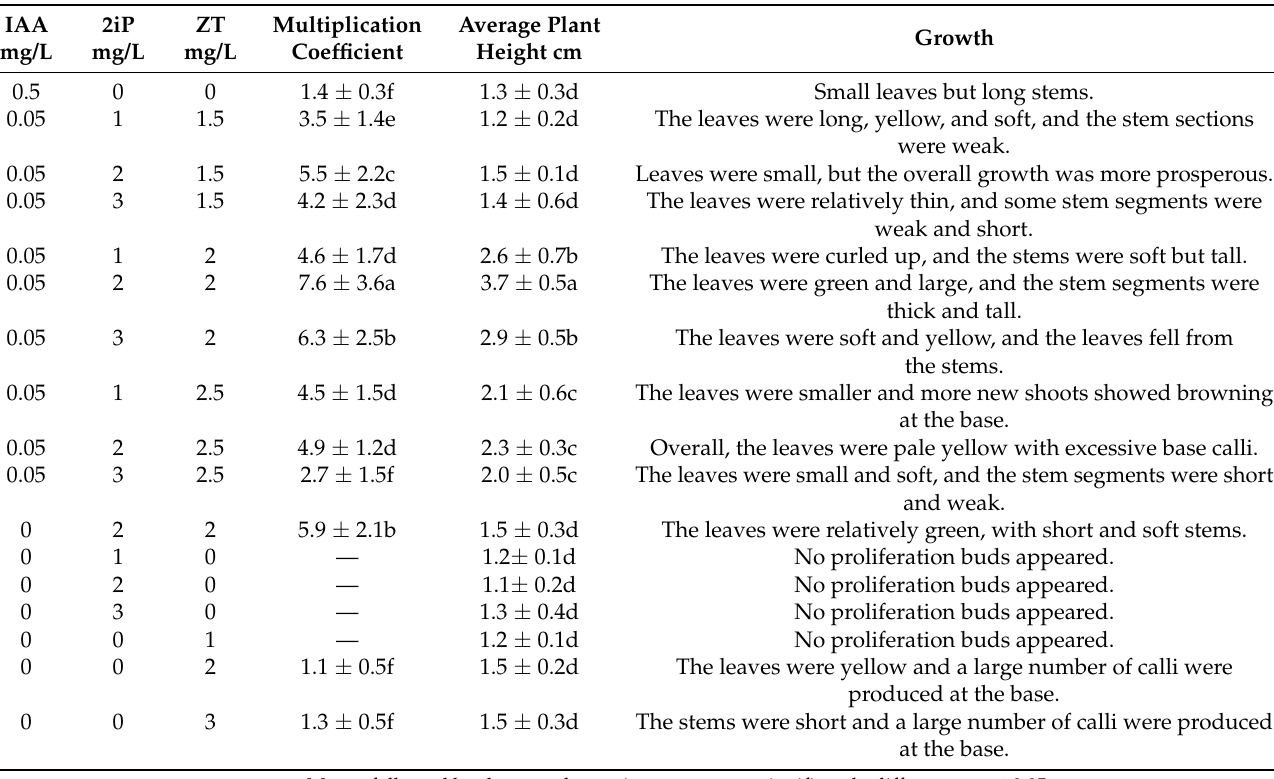
Table 7. Effects of different hormone combinations on the subculture and proliferation of D. lotus .